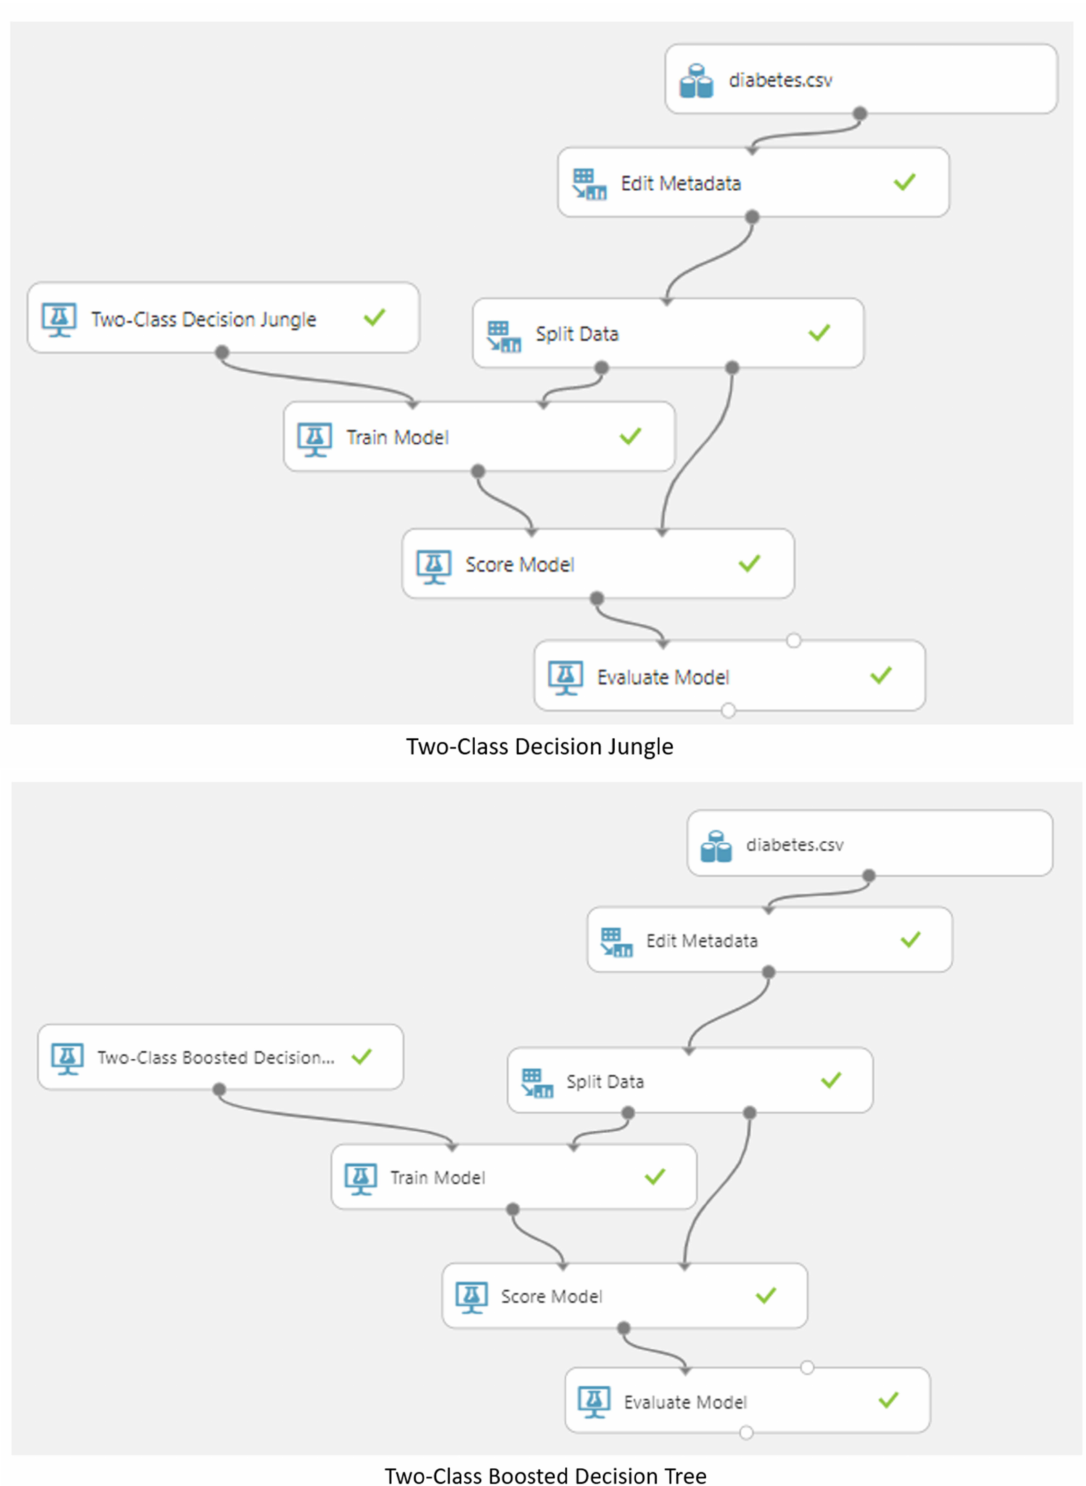
Figure 7. Predictions made by the four different